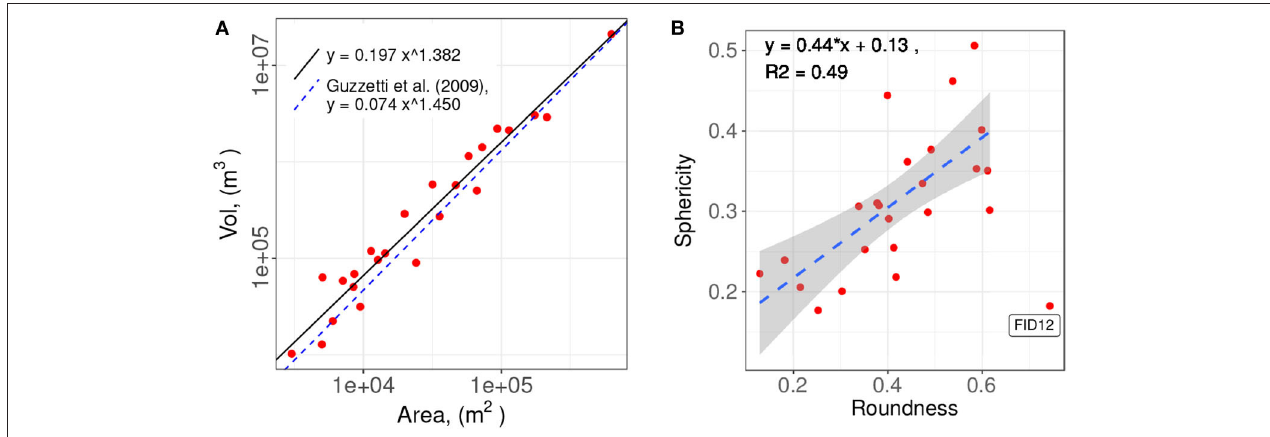
FIGURE 4 | (A) Landslide area and volume relation. (B) Roundness and sphericity relation. The gray area indicates the 95% confidence interval.